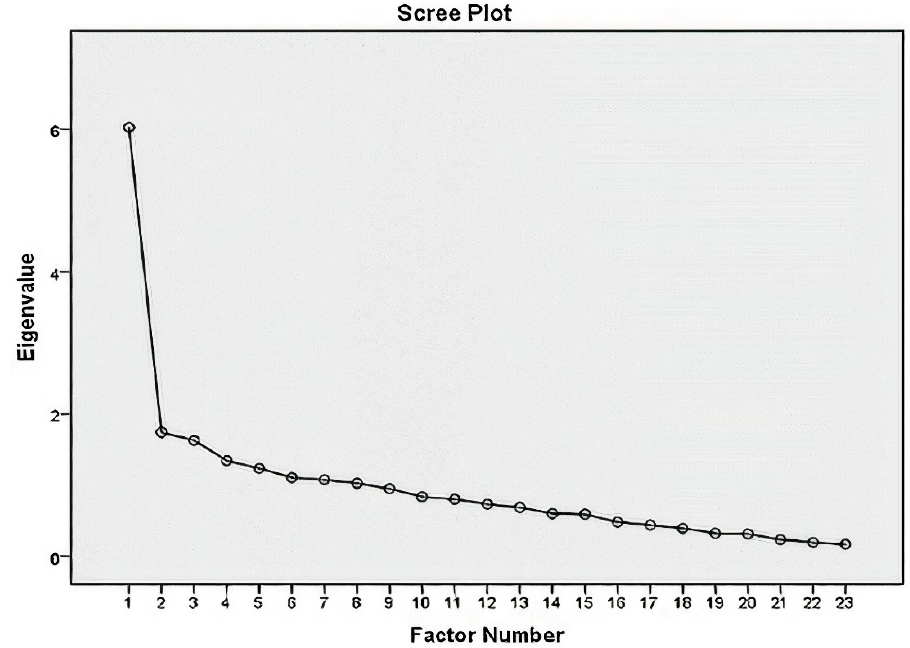
Figure 2. A scree plot via the exploratory factor analysis with the “elbow” at the fifth factor.